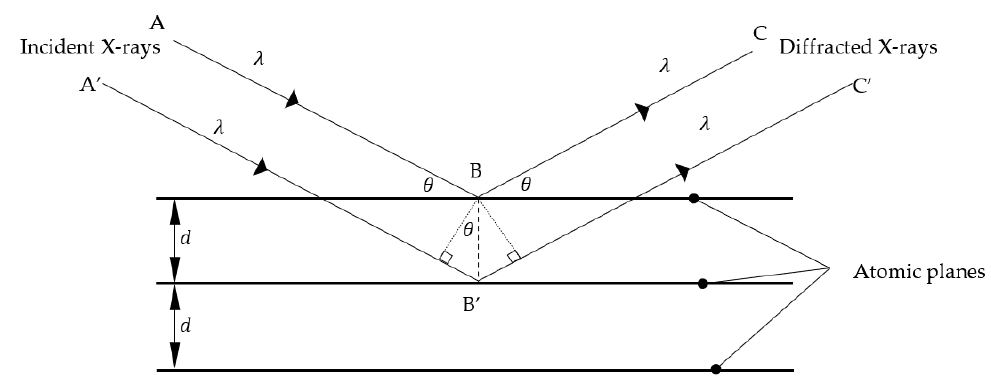
Figure 4. Bragg’s law for diffraction of X-rays in a crystalline structure (path of two incident X- rays represented by ABC and